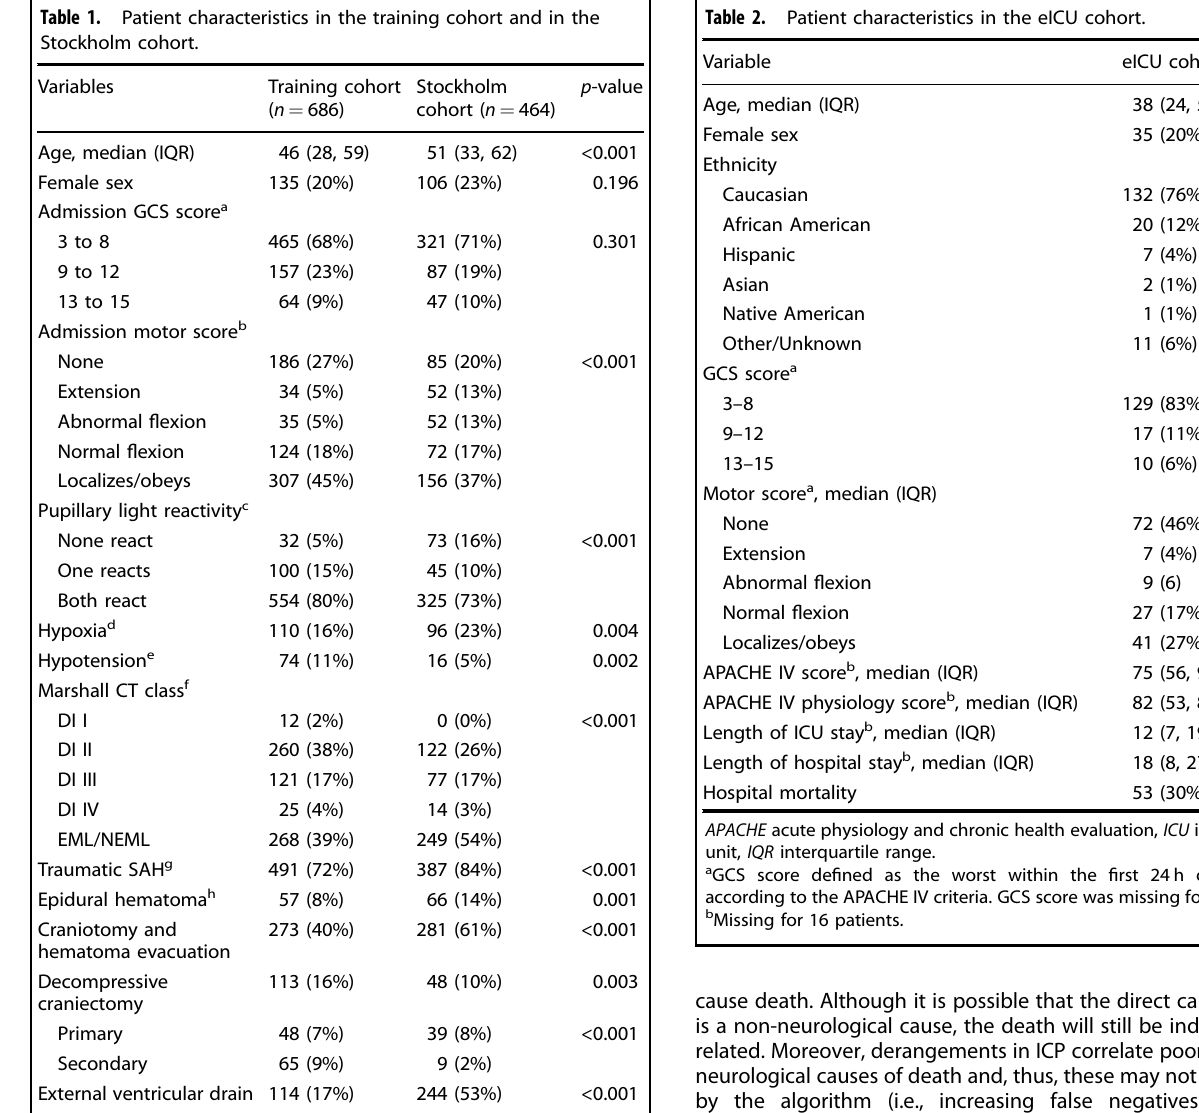
Table 2. Patient characteristics in the eICU